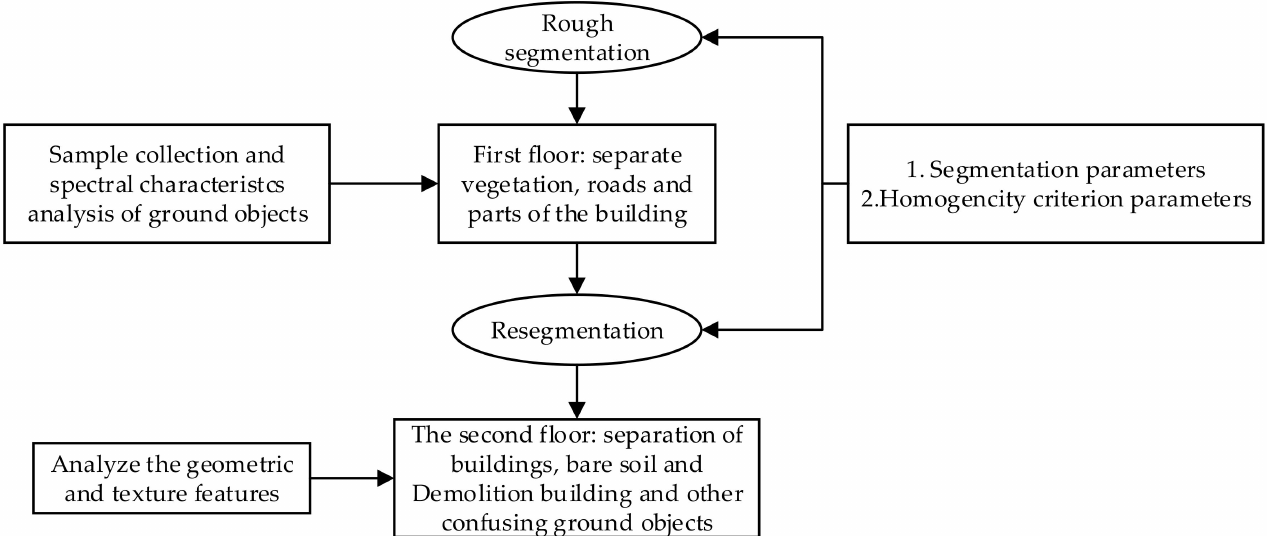
Figure 12. The flowchart of the proposed hierarchical